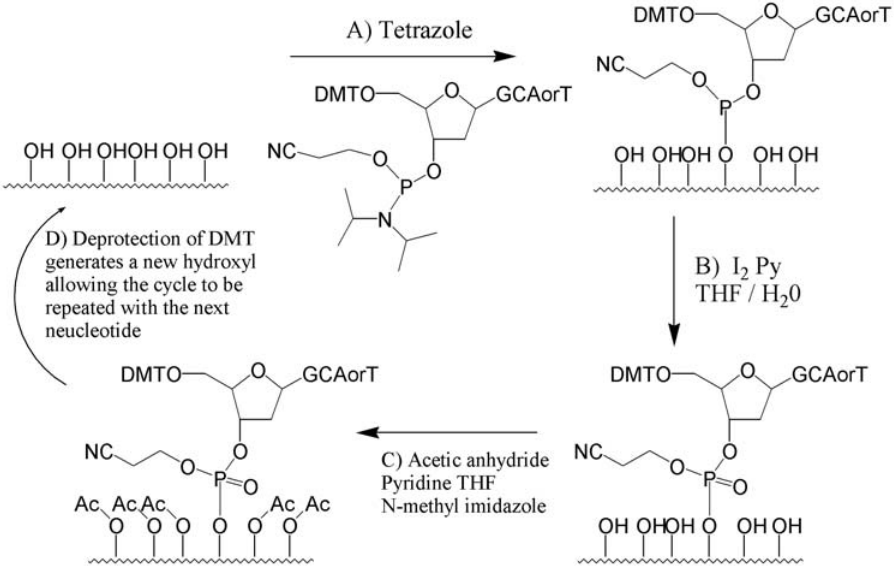
Figure 1. DNA Synthesis Cycle